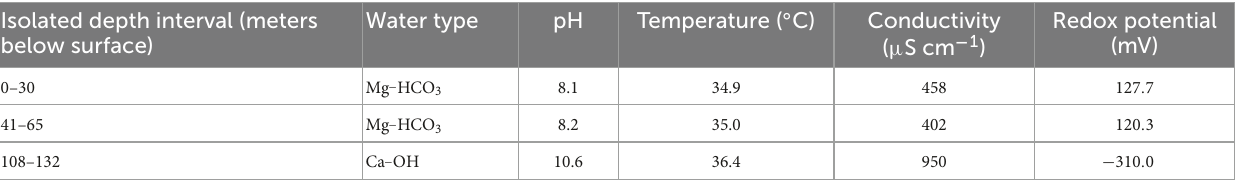
TABLE 1 Select geochemical measurements of waters recovered from discrete depth intervals in well BA1A in February 2019 and their inferred water type. Isolated depth interval (meters below surface)